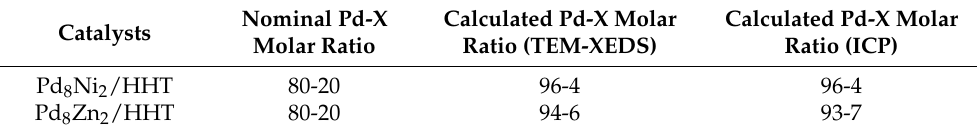
Table 5. Nominal and calculated metal molar ratio for the synthetized catalysts.